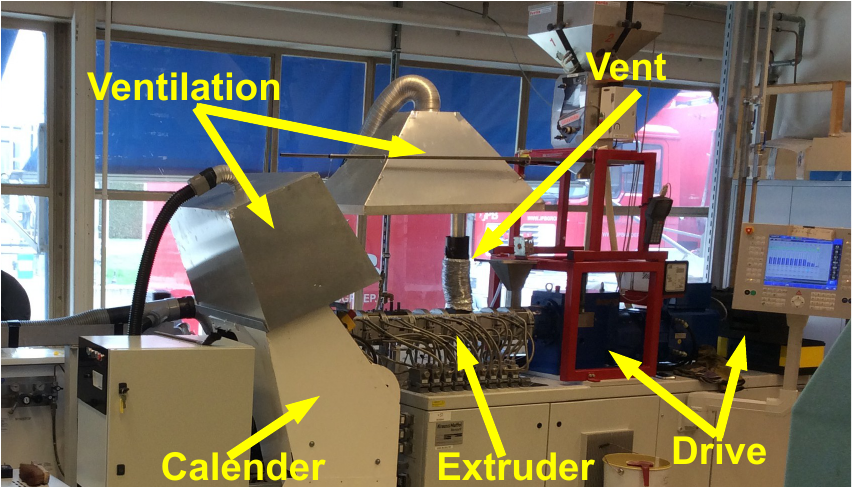
Figure 5. Extruder with calendar and venting